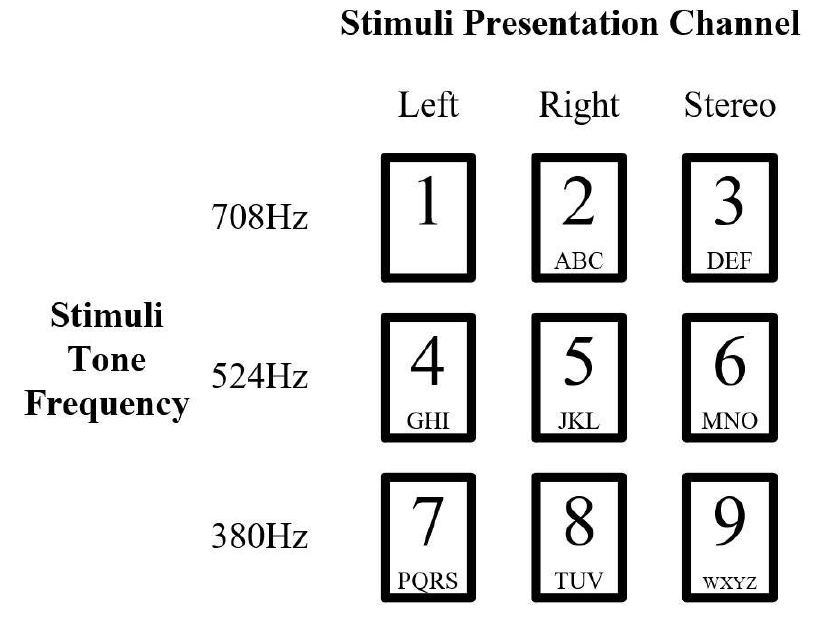
Figure 5. The audio stimuli